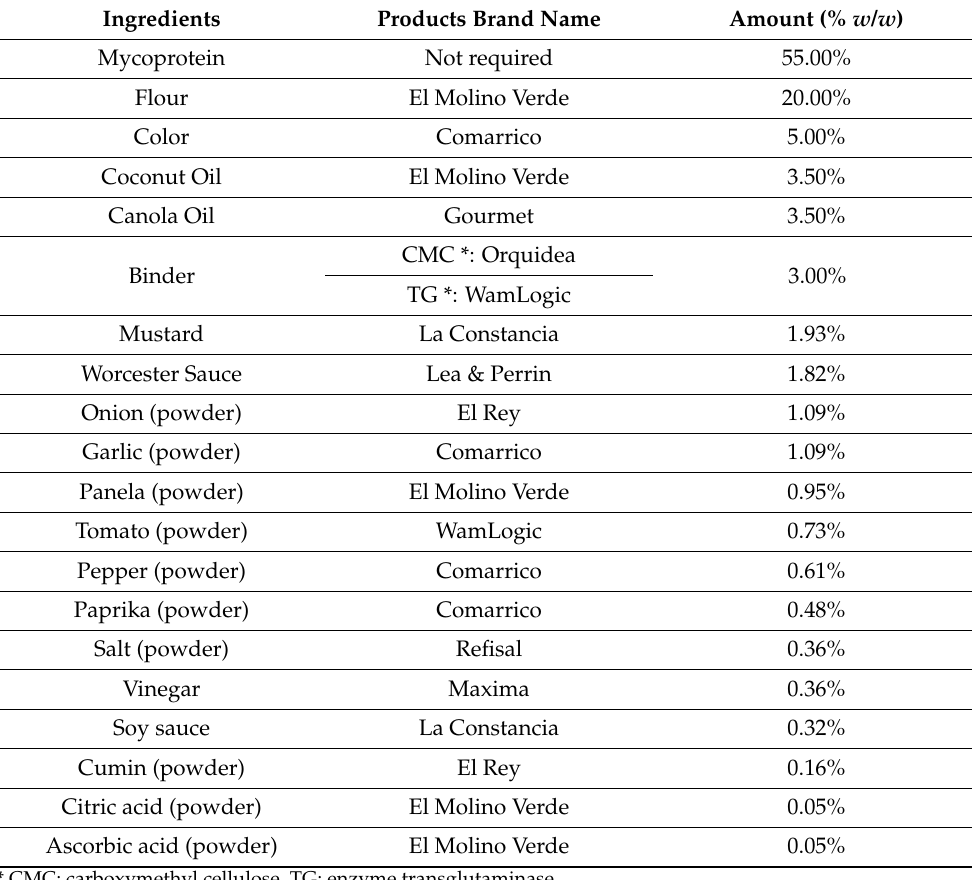
Table 1. General formulation